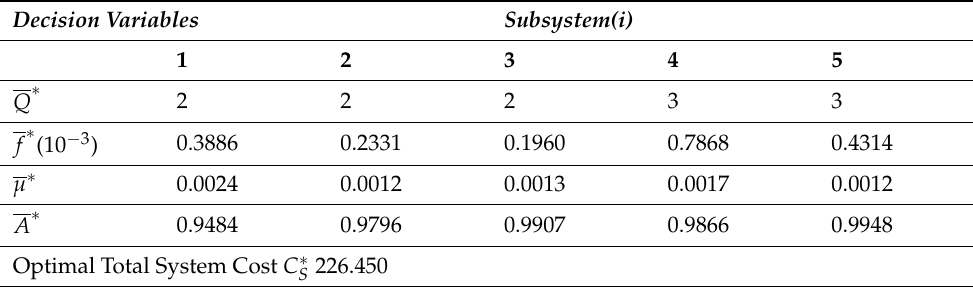
Table 14. Optimal Solutions obtained by MAHA–MGA for the n -stage standby system. Decision Variables